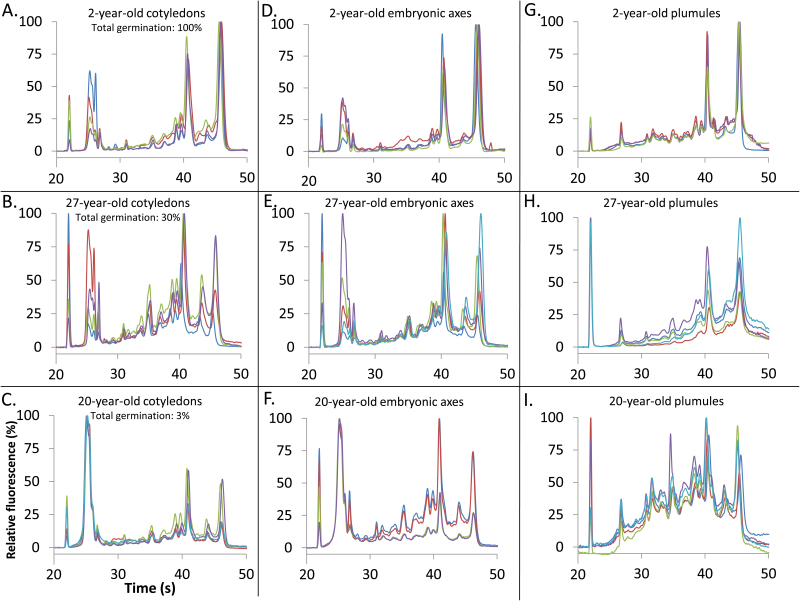
Electropherograms of RNA extracted from soybean seeds harvested in different years with different total germination percentages, transformed to show the percentage of the maximum fluorescence for that RNA sample. Each line indicates the results of a separate RNA extraction. (A) Two-year-old cotyledons (2014 harvest; n=4, average RIN=7.7); (B) 27-year-old cotyledons (1989 harvest; n=5, average RIN=5.5); (C) 20-year-old cotyledons (1996 harvest; n=5, average RIN=4.5); (D) 2-year-old embryonic axes (2014 harvest; n=4, average RIN=8.4); (E) 27-year-old embryonic axes (1989 harvest; n=5, average RIN=6.5); (F) 20-year-old embryonic axes (1996 harvest; n=4, average RIN=4.9); (G) 2-year-old plumules (2014 harvest; n=4, average RIN=6.6); (H) 27-year-old plumules (1989 harvest; n=5, average RIN=6.1); (I) 20-year-old plumules (1996 harvest; n=5, average RIN=4.9). RNA from cotyledons and embryonic axes was extracted using the MMY method, which allows detection of small RNAs that are not as prominent in extractions from plumules using the Qiagen RNeasy kit. Electropherograms from the 2014 cohort include data shown in Fig. 2. (This figure is available in colour at JXB online.)